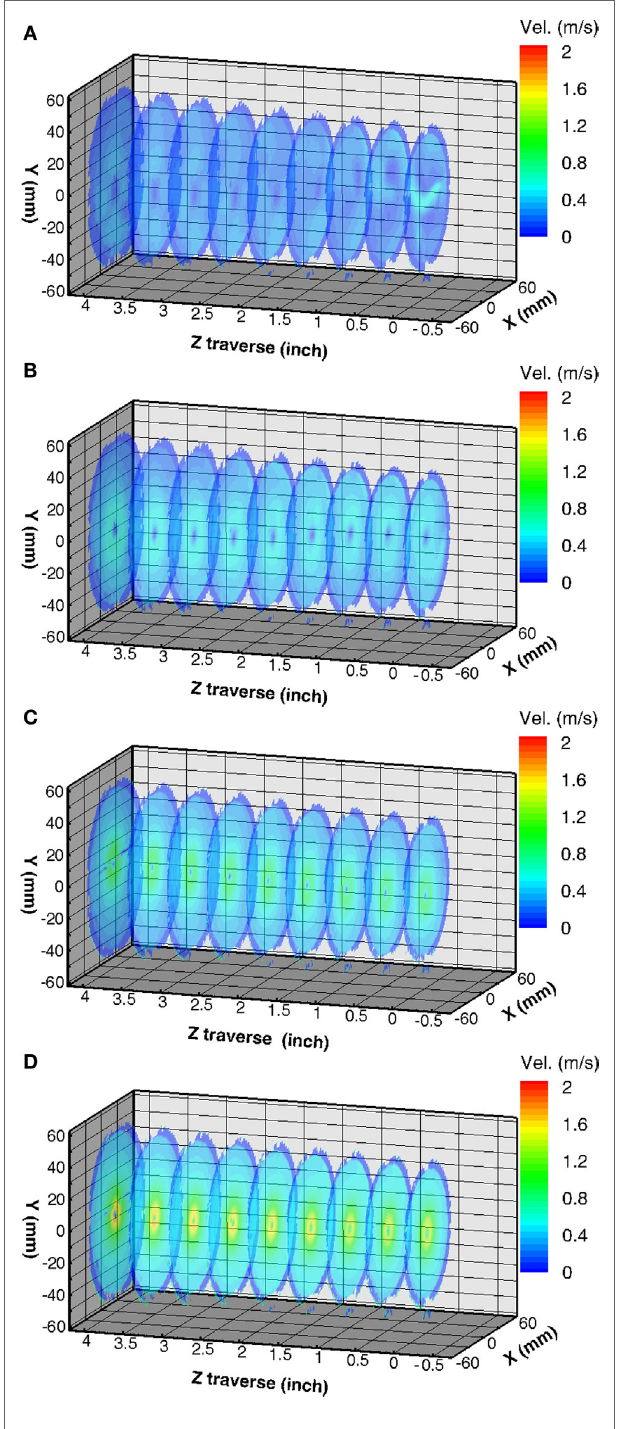
FigUre 5 | Tangential velocity contours at (a) 33 kPa, (B) 50 kPa, (c) 67 kPa, and (D) 101 kPa using Teg particles